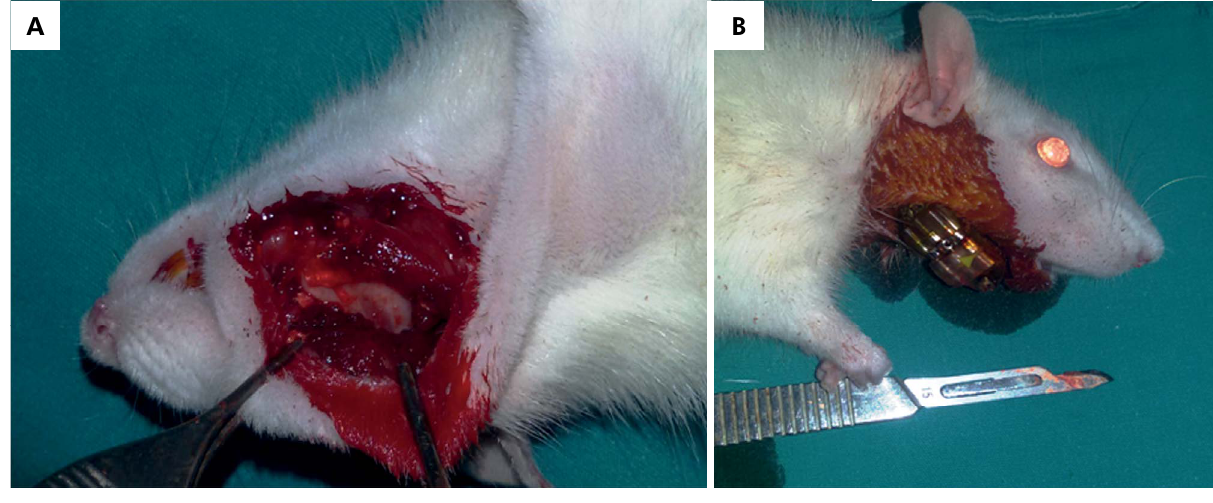
Figure 1. a) Surgical approach of the rat mandible. After the submandibular incision, the subcutaneous tissues and muscles were dissected and mandibular bone was reached. b) After the fixation of the distractor, the subcutaneous tissues and muscles were replaced in their original positions and the surgical area was washed with povidone iodine